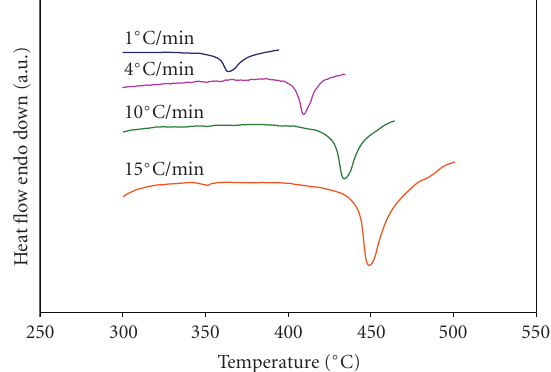
Figure 6: DTA curves of the LiBH 4 /CaH 2 mixture with 25 mol% of TiCl 3 additive as a function of heating rate.